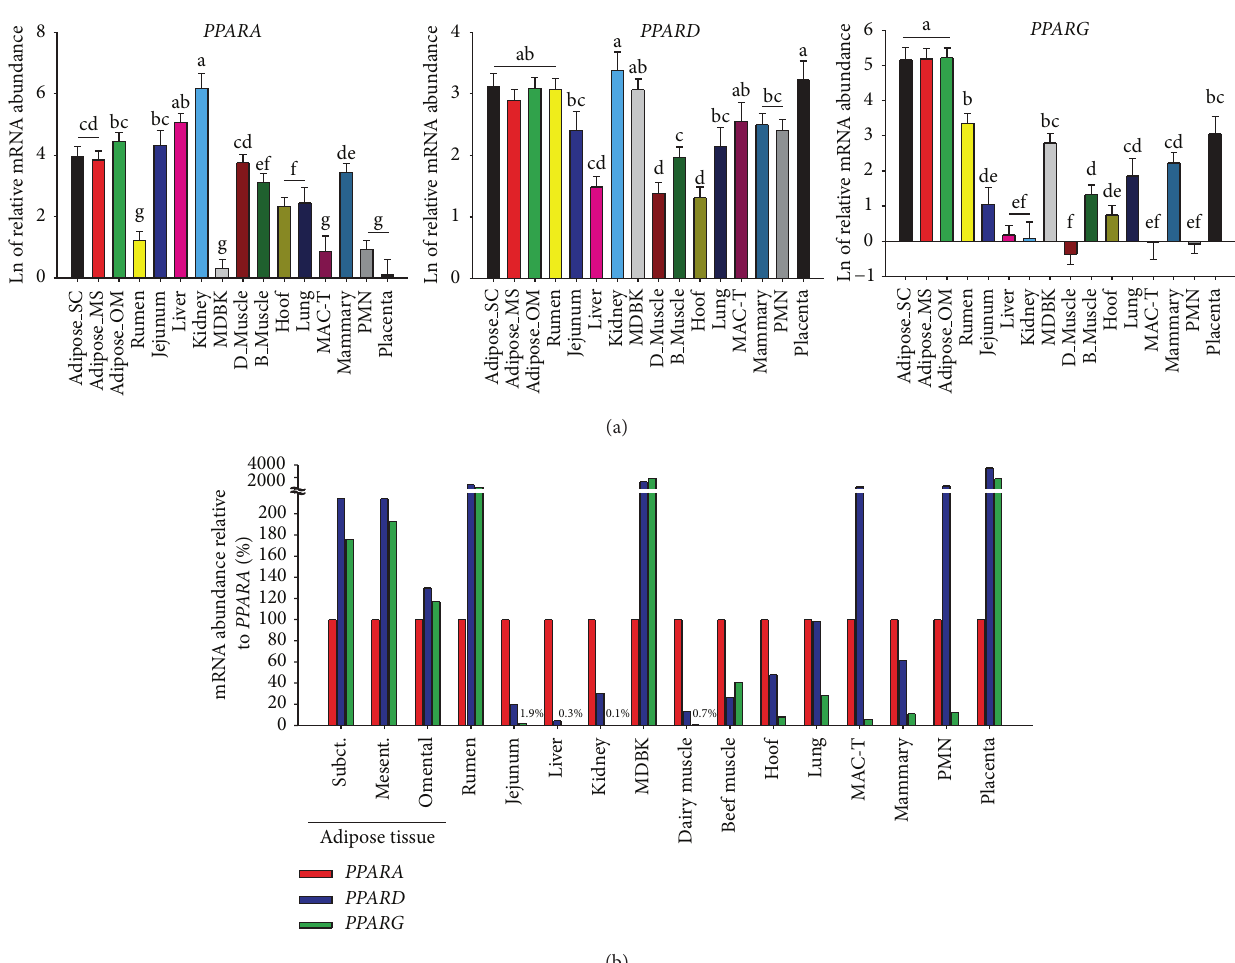
Figure 1: (a) Relative transcript abundance of each PPAR isotype in several bovine tissues and cells. We measured gene expression of PPAR isotypesin14differenttissuesincludingtissuesfromadultdairycattle:adiposetissue(subcutaneous,mesenteric,andomental),smallintestine (jejunum), liver, hoof corium, lung, kidney, mammary gland, blood polymorphonuclear leukocytes (PMN), and placenta; from dairy calves: rumen papillae and semitendinosus muscle (D-muscle); skeletal muscle of beef cattle (Longissimus lombarum ); and two cell lines: Madin- DarbyBovineKidney(MDBK)andbovinemammaryalveolarcells(MAC-T).ThetotalRNAwasextractedandqPCRperformedaspreviously described [26]. The qPCR data were normalized by the geometrical mean of 5 internal control genes ( PPP1R11 , RPS15A , ACTB1 , MRPL39 ,